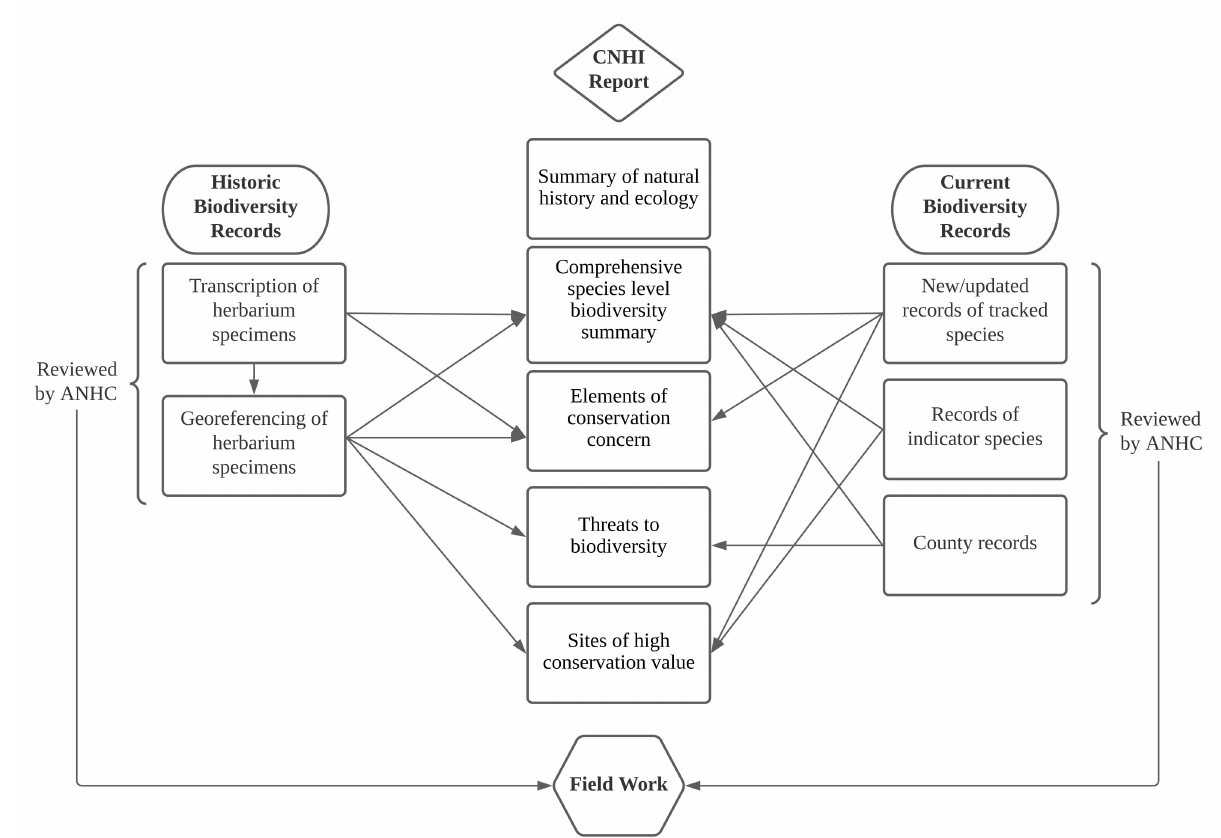
Figure 3. Citizen scientists’ contributions to historic and current biodiversity records and where they impact the County Natural Heritage Inventory (CHNHI) report. For historic biodiversity records, citizen scientists transcribe herbarium specimen records into standardized databases. The locality information from the record is then georeferenced. For current biodiversity records, iNaturalist observations are reviewed by ANHC staff to identify new records of tracked taxa or update known records of tracked taxa, where tracked taxa are those of conservation concern. Records of indicator taxa, which have high conservation value, and county records are also